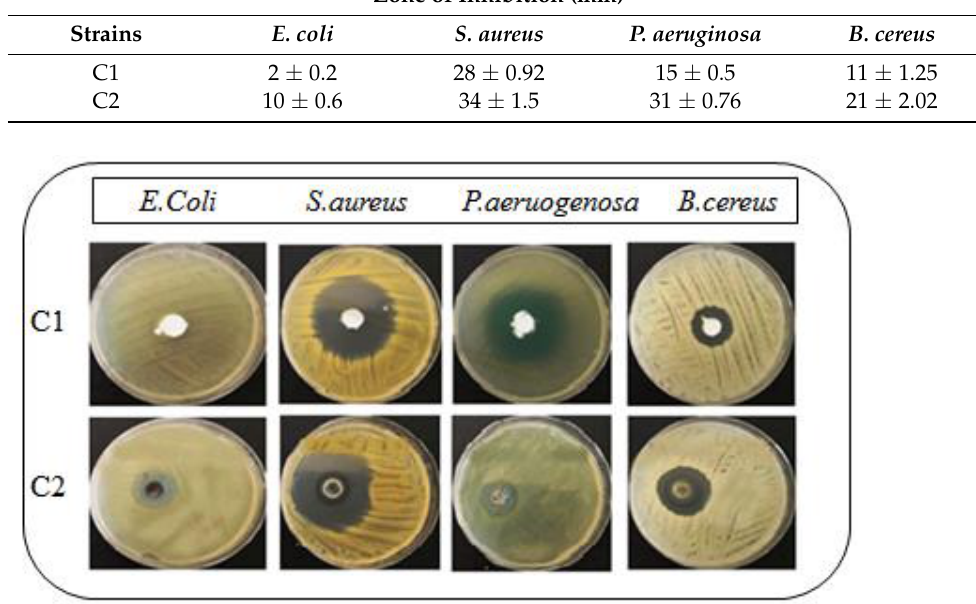
Figure 5. Antibacterial activity of the prepared formulations (C1 and C2) against various bacterial strains.